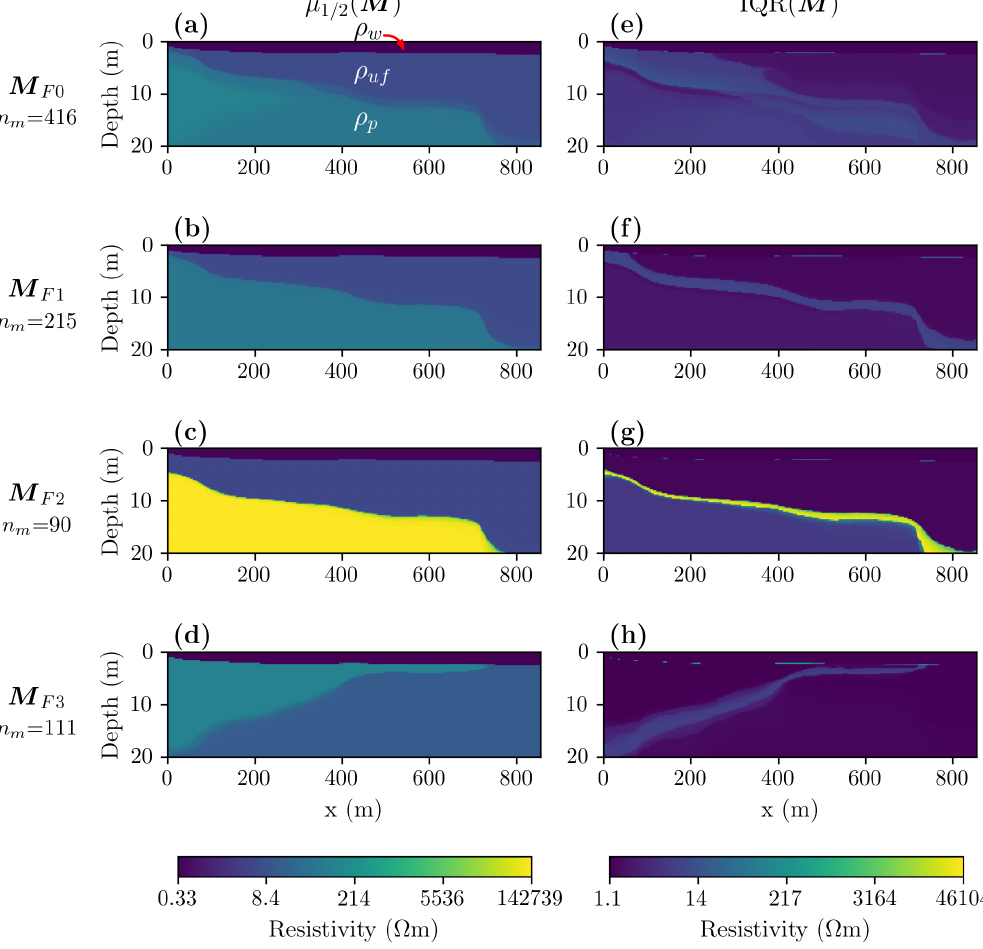
Figure 7. Inversion results for the Drew Point data set illustrated as summary statistics for all obtained models M F0 and for three model families M F1 , M F2 , and M F3 as found by cluster analysis. (a–d) Median and (e–h) interquartile range models. For each M Fi , n m represents the number of models in the corresponding